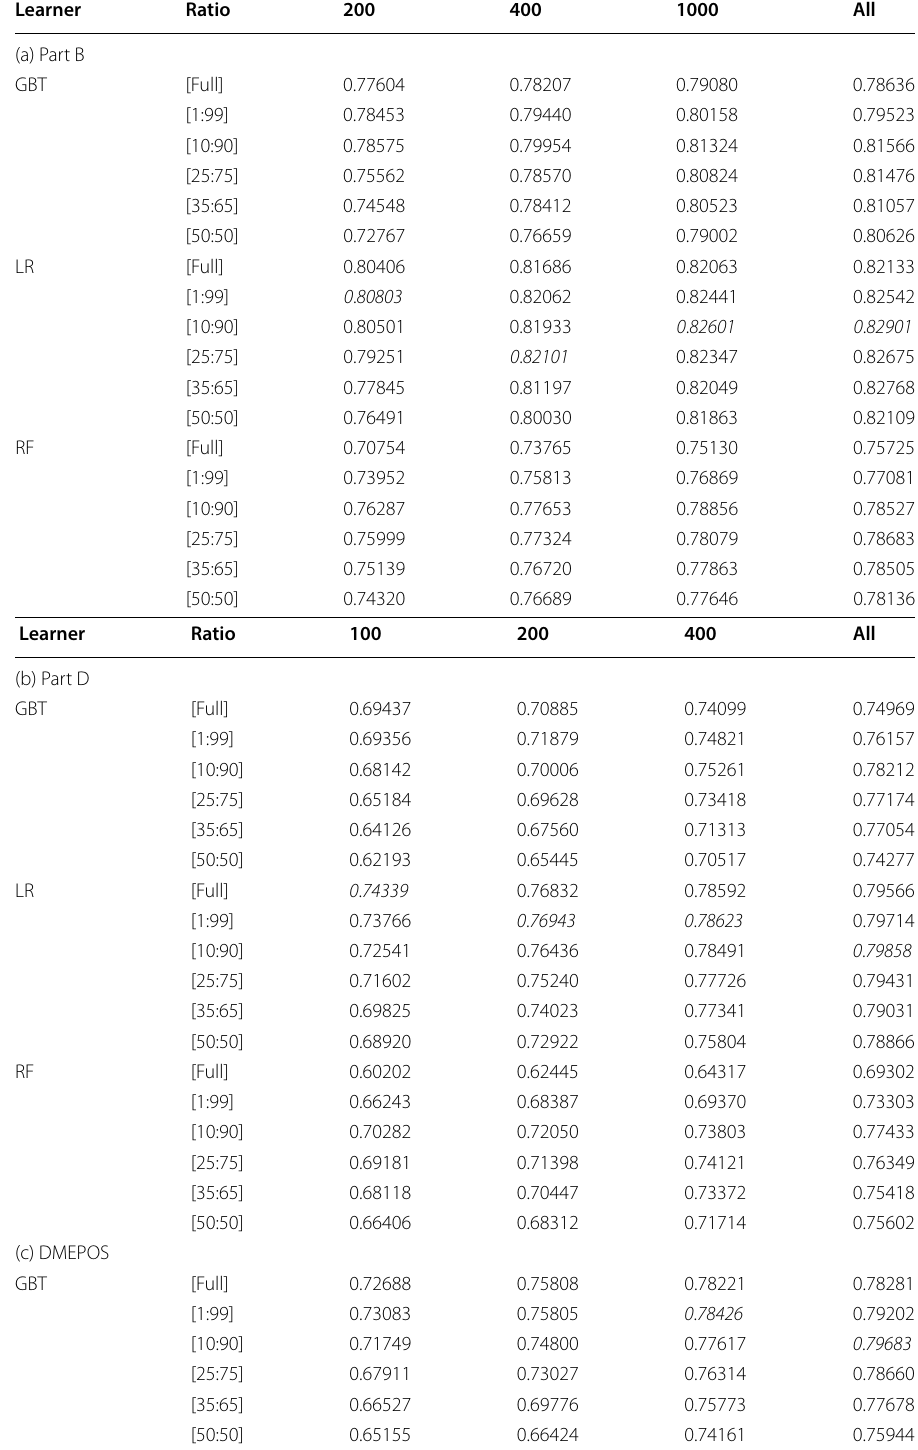
Table 5 AUC results for